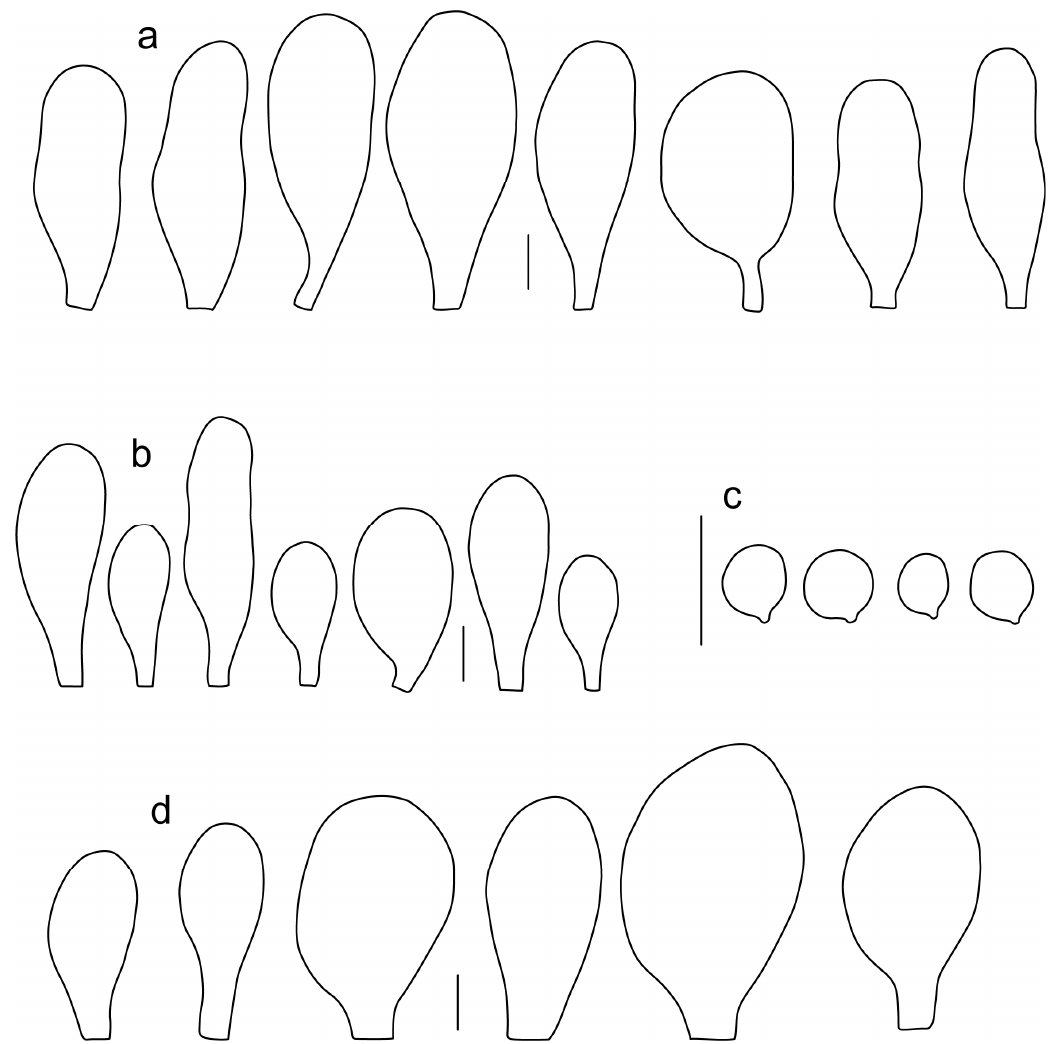
Figure 13. Pluteus parvisporus ( a ). pleurocystidia, ( b ). cheilocystidia ( c ). basidiospores, ( d ). pileipellis elements. Scale bars 10 µm.